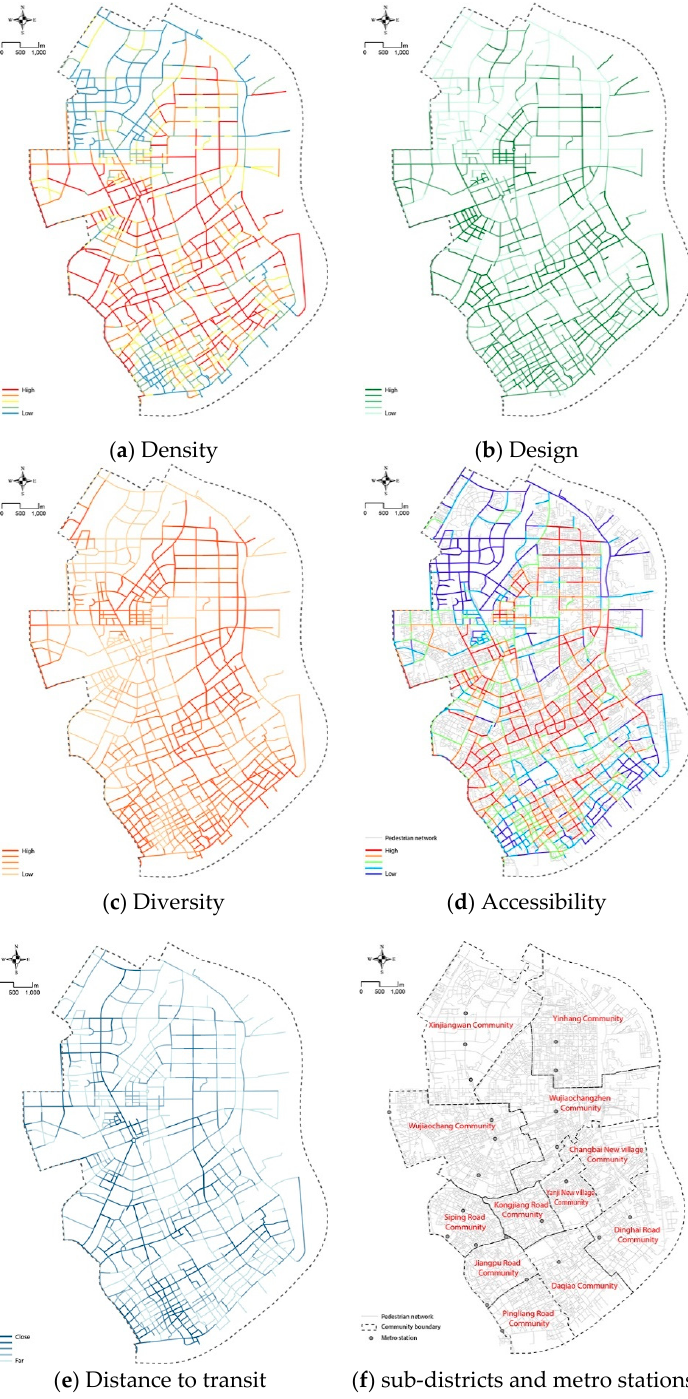
Figure 12. Measuring built environment elements of street quality.